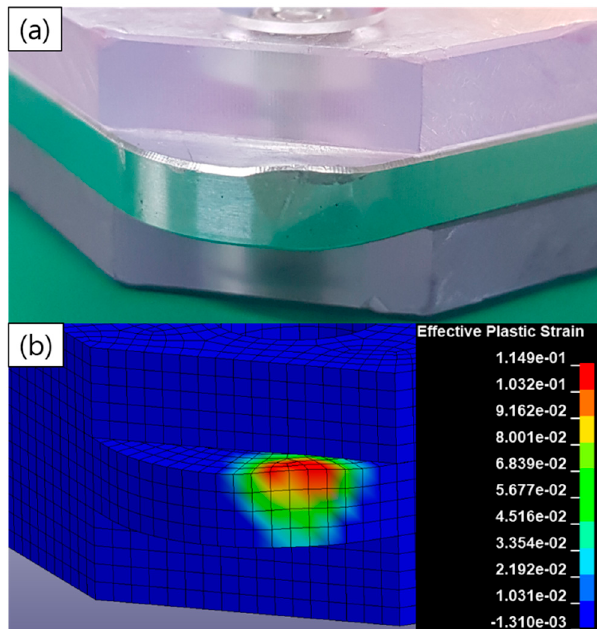
Figure 8. Plastic strain of the dummy after ( a ) the impact test and ( b ) analysis.